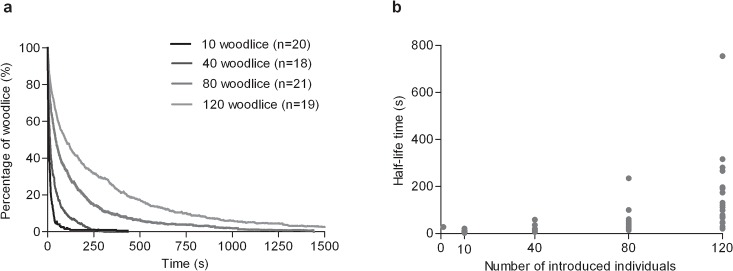
According to number of woodlice initially introduced, the dynamics of the dispersion of groups held for 300 s (a) and the time necessary to disperse 50% of the population introduced (half-life time) (b).For the experiment with 120 woodlice, only the first 1500 s were represented in Fig 1a for better visibility, but some aggregates persisted for more than 4300 s with 120 individuals.